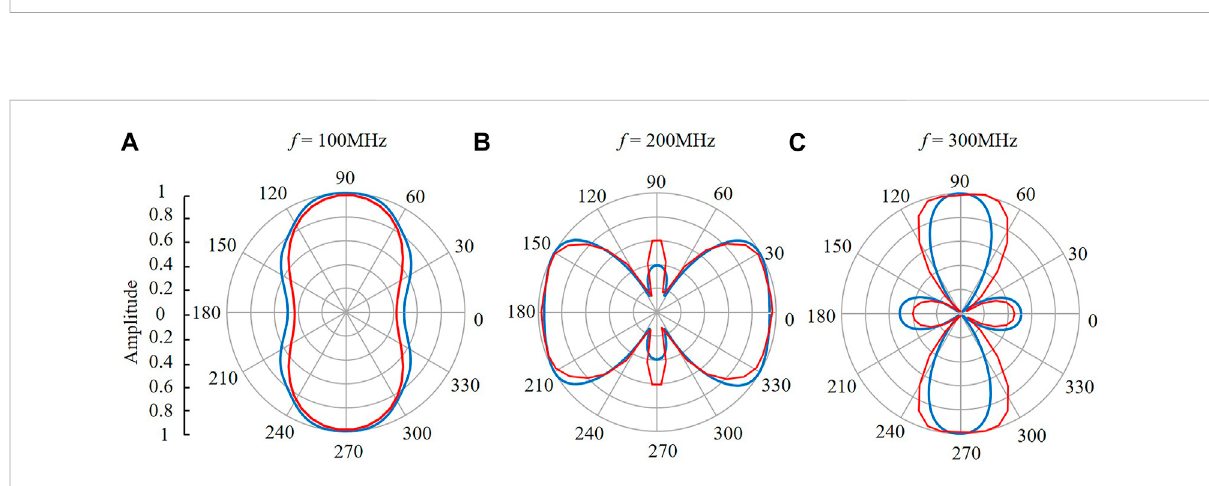
Polar distribution patterns of the photoacoustic amplitude at the far- fi eld ξ = 6 for various frequencies. (A – D) Respectively for the frequency of 40, 100, 200 and 300 MHz. The amplitude distribution of each frequency is normalised to its maximum value, which were 0.0073, 0.0085, 0.0024, and 0.0027.